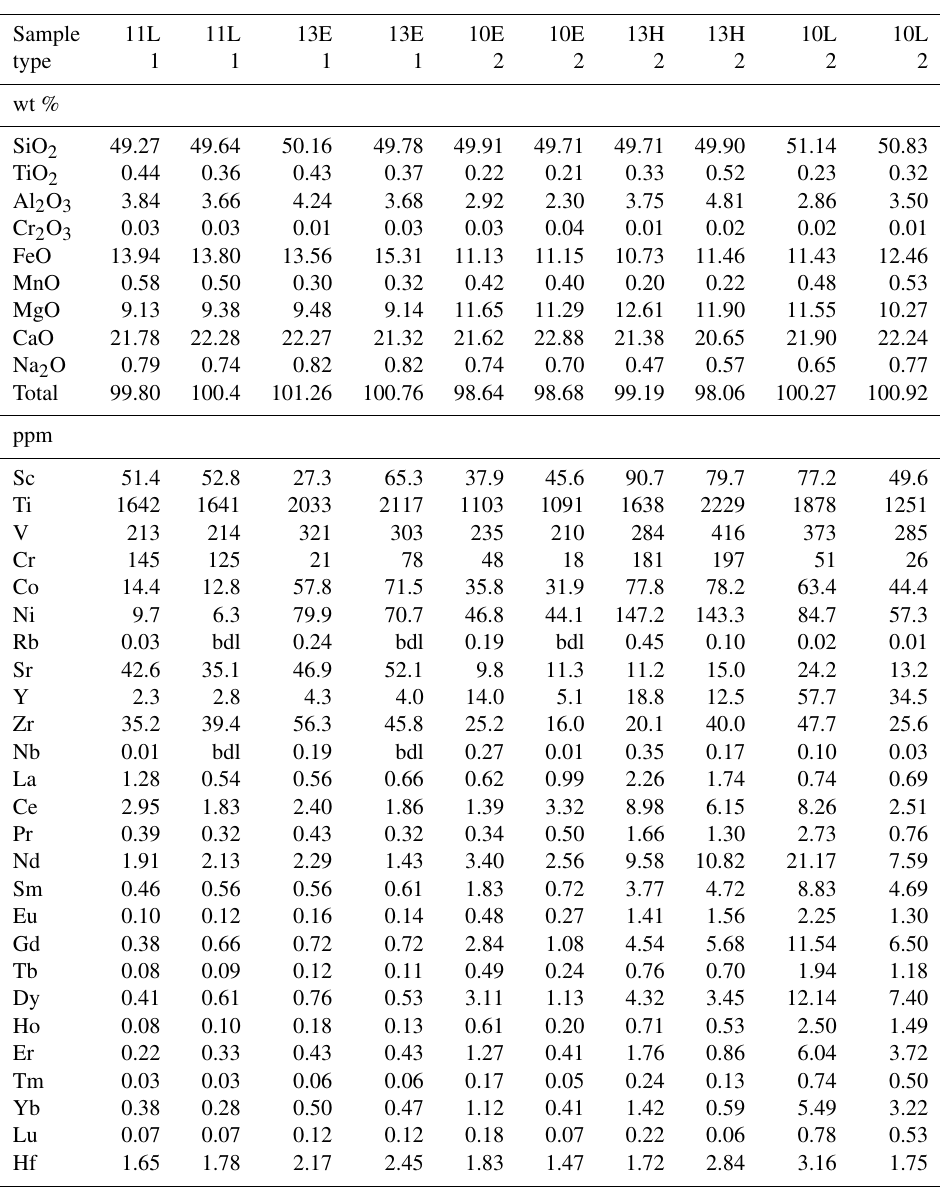
Table 3. Major and trace element of clinopyroxene.